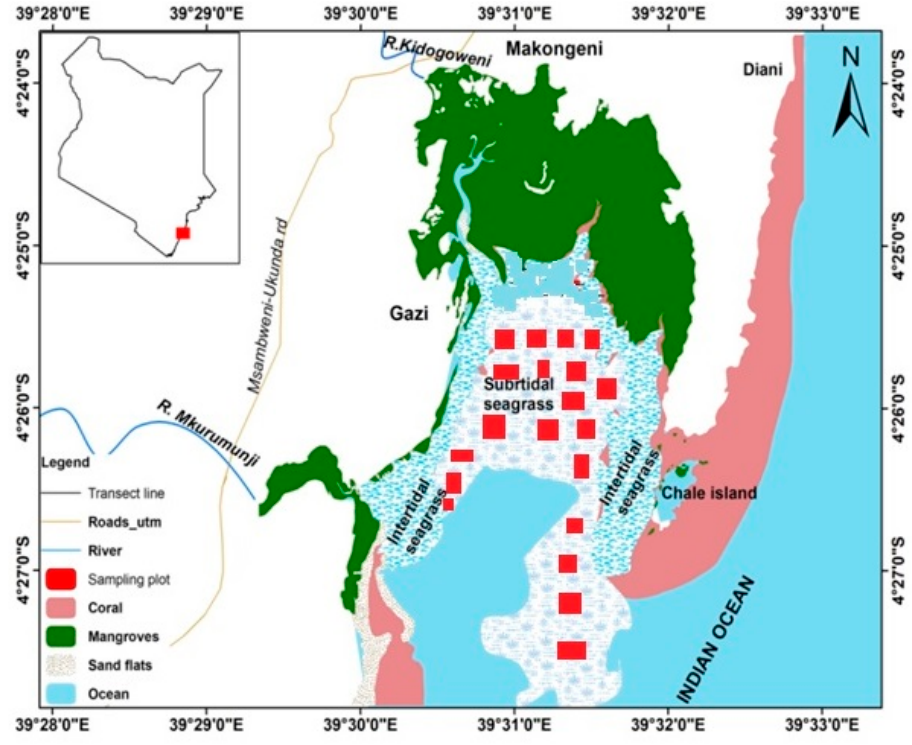
Figure 1. Map of Gazi Bay, indicating the sampling points in subtidal seagrass area. Source: [31]. The embayment is protected from strong waves by the Chale peninsular located to the east and a fringing reef to the south, and has a shallow, wide opening to the open ocean [29]. Freshwater flows into the area via the River Kidogoweni in the northwest and River Mkurumudzi in the southwest of the bay [29]. Kinondo creek, located in the northeastern side of the bay, is the only channel that lacks fresh water supply and is regulated by tidal movements.